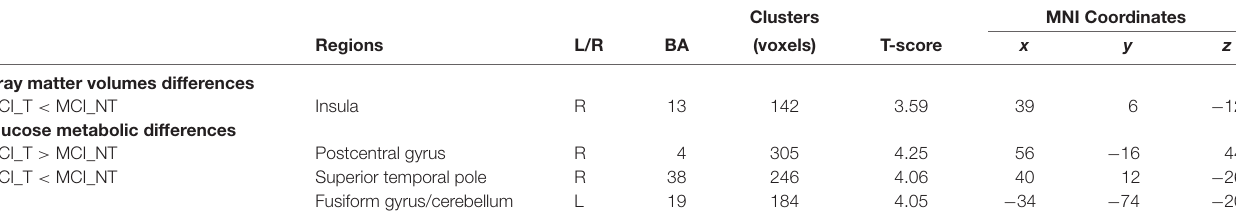
TABLE 2 | Brain regions showing significant gray matter (GM) volume or glucose metabolic differences between MCI_T and MCI_NT groups. Clusters MNI Coordinates Regions L/R BA (voxels) T-score